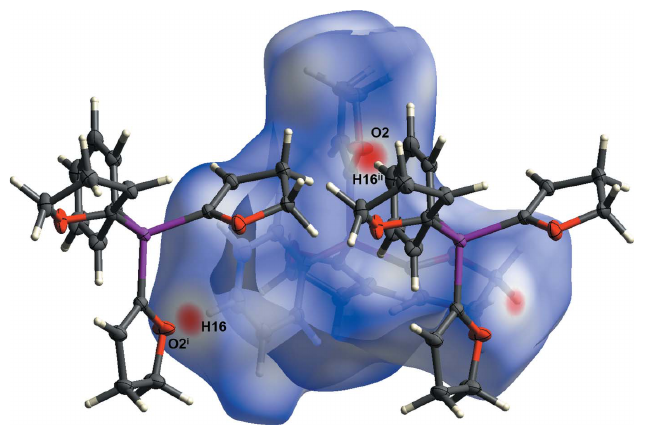
Figure 8 Hirshfeld surface analysis of 2 showing close contacts in the crystal. The weak hydrogen bond between oxygen atom O2 and the H16 hydrogen atom is labelled. [Symmetry codes: (i) (cid:5) x + 1, y + 1 y (cid:5) 1 , (cid:5) z + 3 ]. 2 2 Fig. 7. Again, the strengths of the hydrogen bonds can be classified as weak (Desiraju & Steiner, 1999). A Hirshfeld surface analysis of 2 was carried out with d from (cid:5) 0.1662 to 1.2663 a.u.. The characteristic red spots in Fig. 8 indicate the C16—H16 (cid:2) (cid:2) (cid:2) O2 i interactions. The two- dimensional fingerprint plots are displayed in Fig. 9.